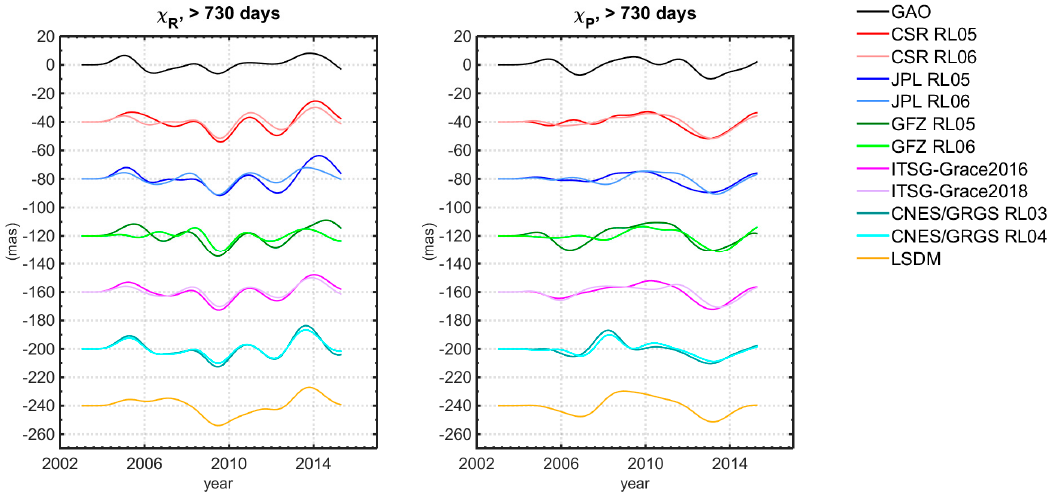
Figure 7. Retrograde and prograde parts ( χ R and χ P , respectively) of long-term ( > 730 days) non-seasonal variation in GAO, in HAM computed from different GRACE solutions, and HAM from the LSDM. The units are milliseconds of arc (mas). For better visibility, a bias was added to various HAM in order to shift them relative to each other.